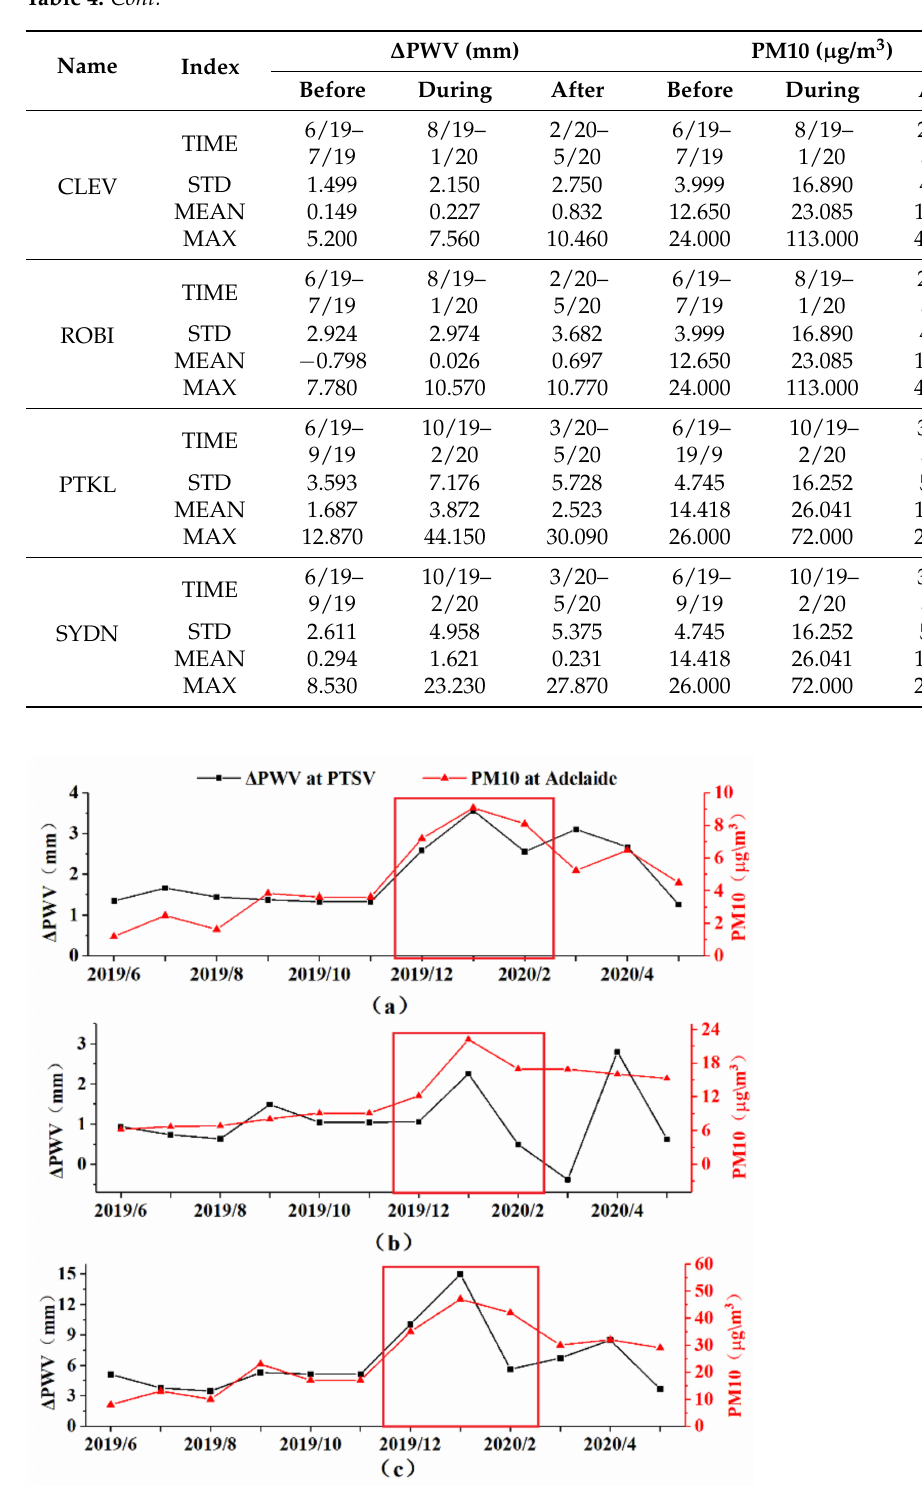
Figure 2. Statistical results of ∆ PWV and PM10 at PTSV (( a ) standard deviation (STD) statistics, ( b ) mean (MEAN) statistics, ( c ) maximum (MAX) statistics of